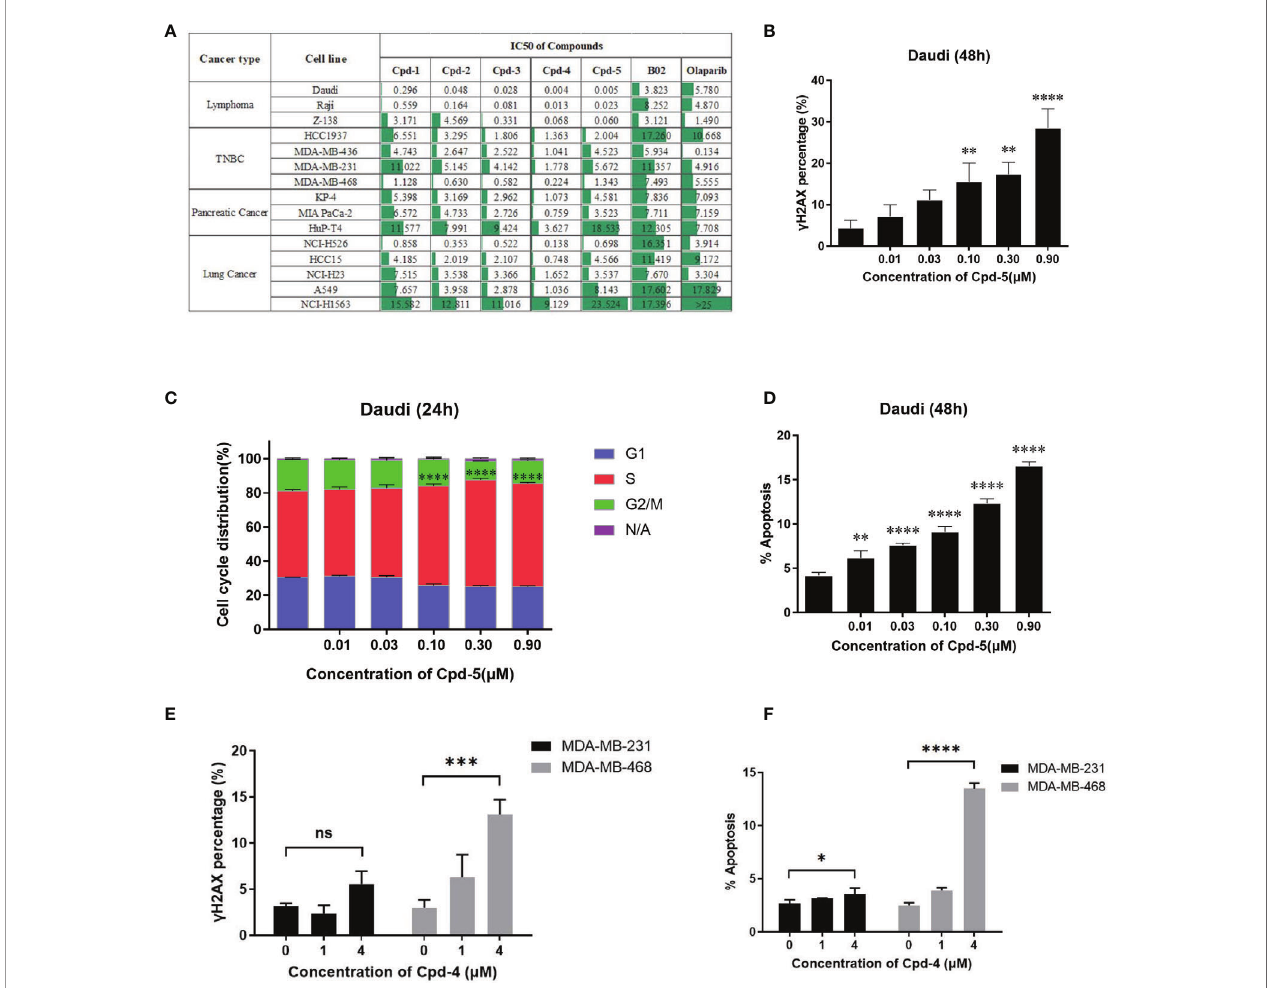
FIGURE 3 | RAD51 inhibition attenuates growth of various types of tumor cells and induces cell cycle arrest. (A) Estimated IC 50 values ( m M) of a series of RAD51 inhibitors and Olaparib on different cancer cell lines based on the four ‐ parameter dose response curve generated in GraphPad prism. Data are representative of at least three independent experiments. (B) Dose-dependent g H2AX expression under compound treatment was analyzed by fl ow cytometry. Statistical analysis was performed comparing Cpd-5 treated cells with non-treated cells. (C) Cell cycle analysis of Daudi cells after compound treatment for 24 hours. Cells were stained with PI and images were analyzed by fl ow cytometry. N/A (non-assigned) represents cell populations where signal intensities exceeded the threshold to accurately determine the cell cycle phase. Statistical analysis was performed using percentage of cells in S-phase treated with Cpd-5 comparing with non-treated cells. (D) Induction of apoptosis in Daudi cells by compound treatment in a dose-dependent manner at 48 h. Statistical analysis was performed comparing Cpd-5 treated cells with non-treated cells. (E) Quantitative data from fl ow cytometry analysis showing percentage of g H2AX positive cells in MDA-MB-468 and MDA-MB-231 cell lines after compound treatment. (F) Analysis of apoptosis by fl ow cytometry in MDA-MB-468 and MDA-MB-231 cell lines following treatment with compounds for 48 h. All data presented with mean ± SD are based on at least three biological repeats. *, P<0.05; **, P <0.01; ***, P <0.001; ****, P <0.0001; NS, not signi fi